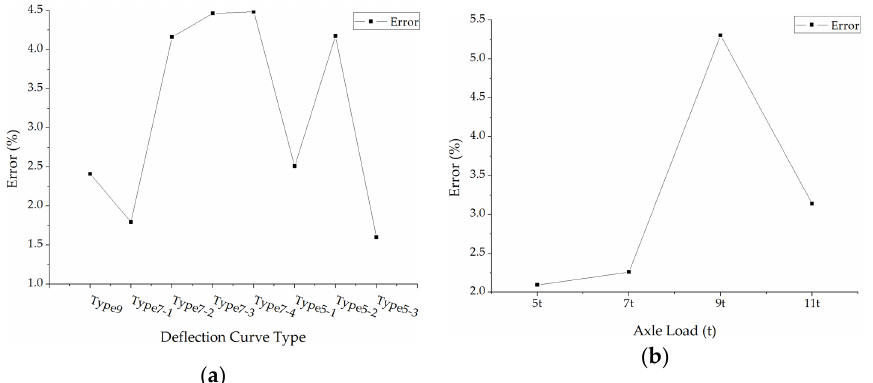
Figure 9. The errors of back calculated subbase modulus under different deflection curve types: ( a ) Structure 5; ( b ) Structure 6.